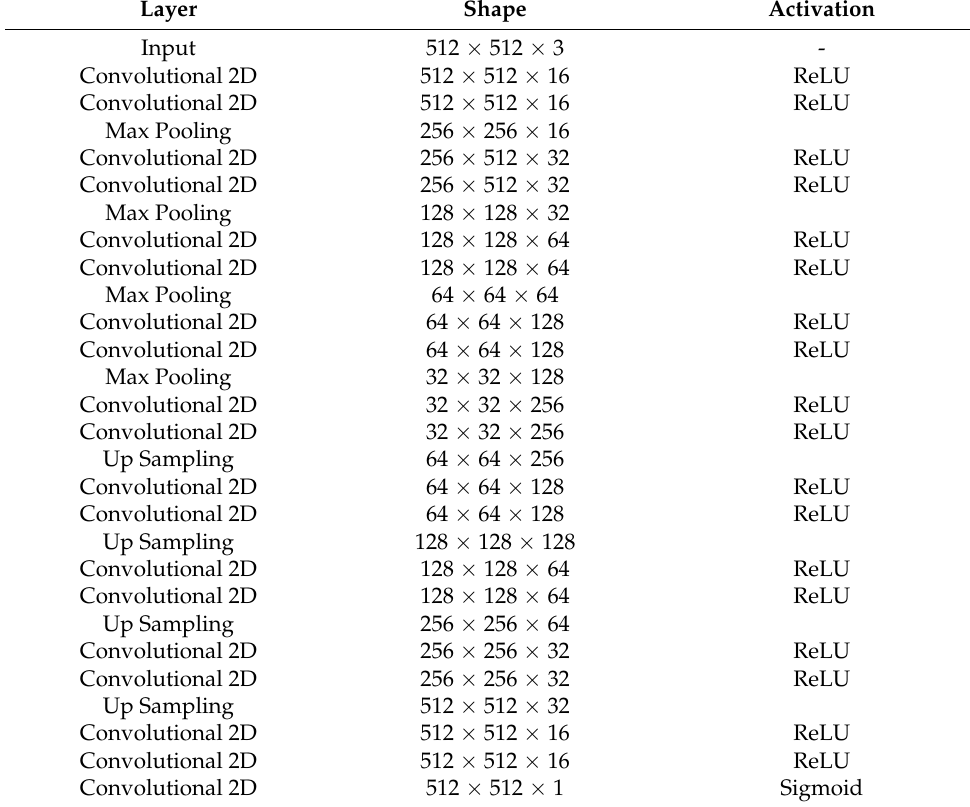
Table 2. The shapes of layers used for the U-Net-based maceral segmentation